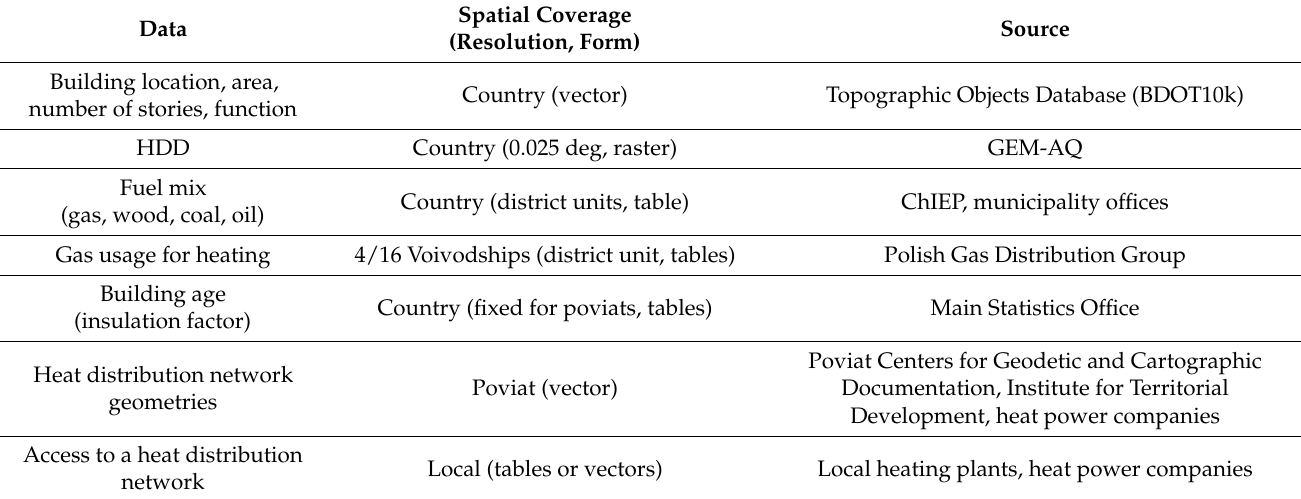
Table 1. Input data used for residential emission